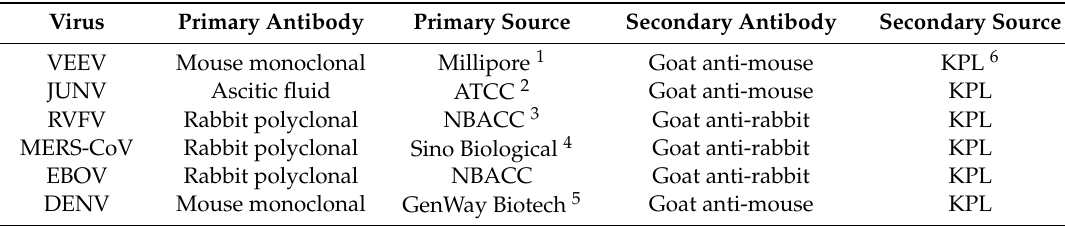
Table 1. Immunofluorescence assay (IFA)